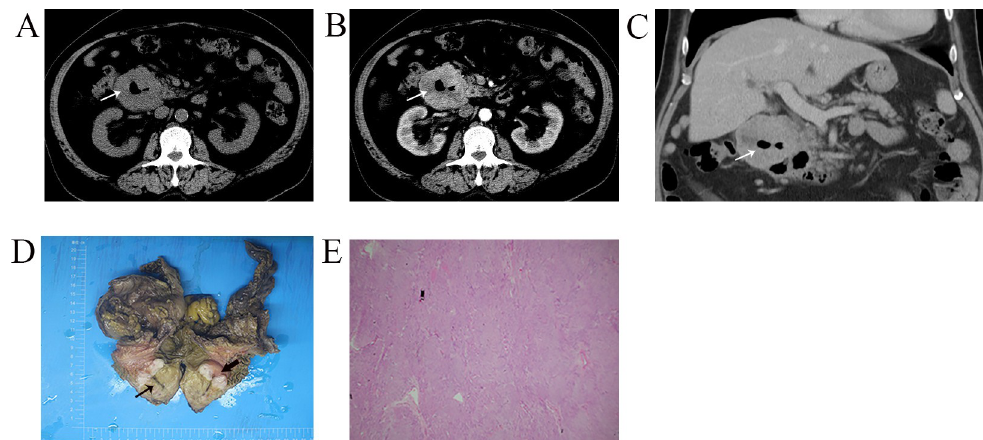
Fig 2. Representative CT images and histological examinations of duodenal GIST with an air-fluid level. (A-C) Enhancement of duodenal GIST and air-fluid level within the mass (white arrow); (D) The fistula (black arrow) and fistula opening (black arrowhead) between the wall of duodenum and mass;. (E) Histopathological result by H-E staining showed the spindle cells (magnification, x100).